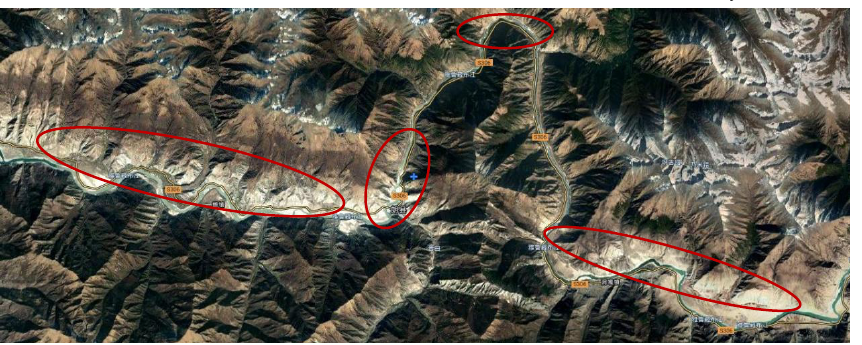
Figure 7 . Susceptibility map of rainfall-type debris flow in the study area.